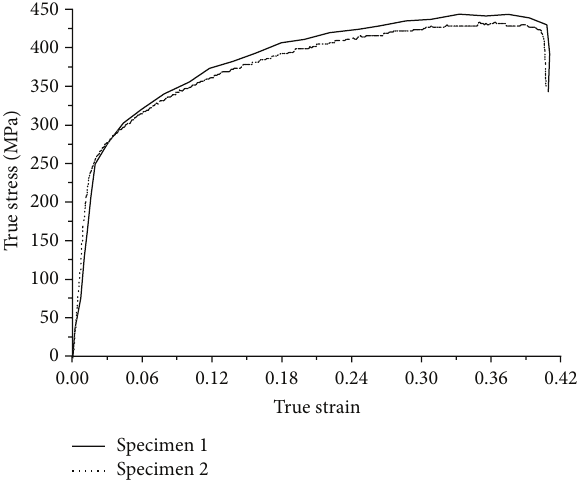
Figure 2: Quasi-static tensile stress-strain curves of H62 brass.